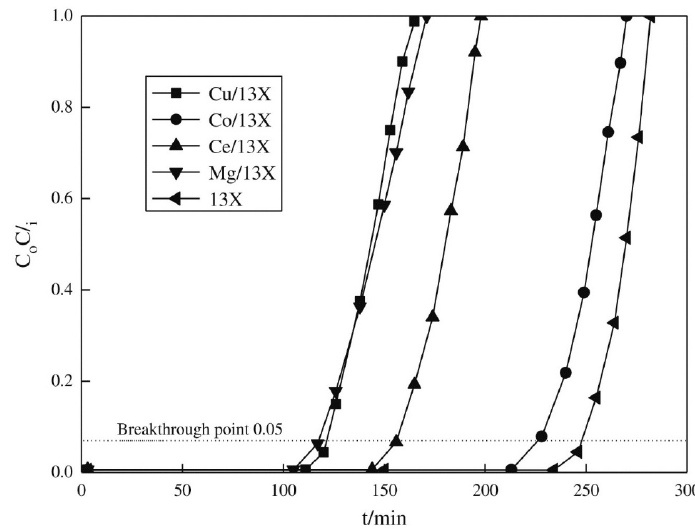
Figure 13. Adsorption breakthrough curves of 13X supported catalysts. Reprinted from Reference [88], with permission from John Wiley and Sons.